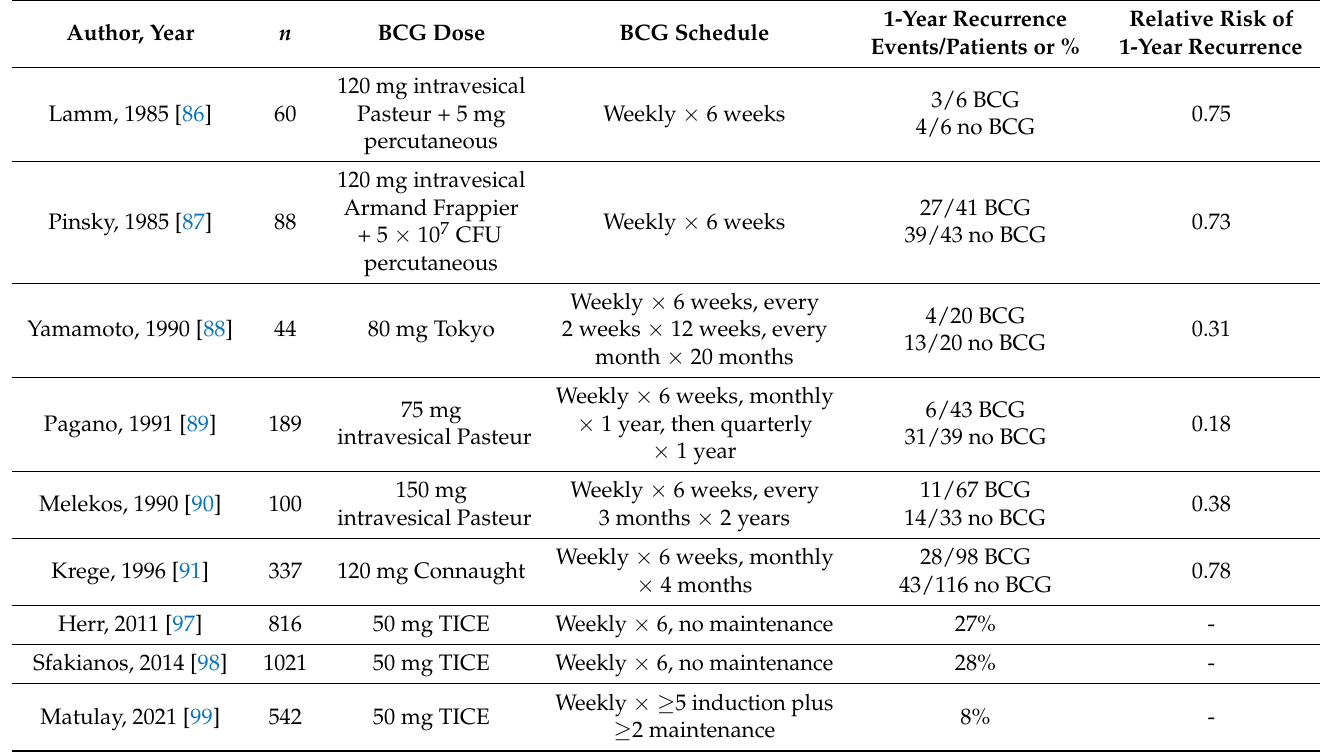
Table 1. Clinical trials assessing recurrence-free survival after BCG